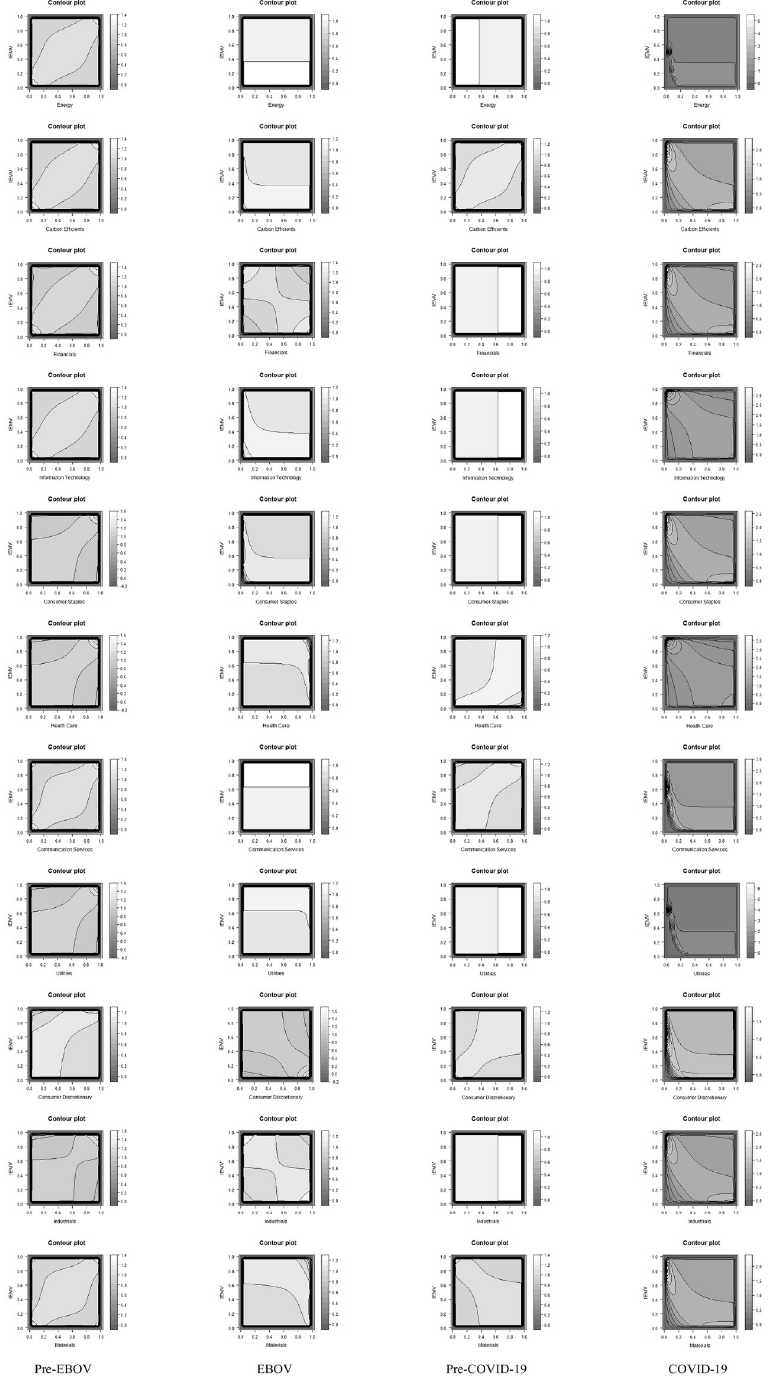
Fig 5. Contour plot of each bivariate copula function for every four periods. The contour plot of the bivariate copula highlights the asymmetry and tail dependence in joint distribution at pre-EBOV and pre-COVID-19 periods ( https://ndownloader.figshare.com/files/29099883).